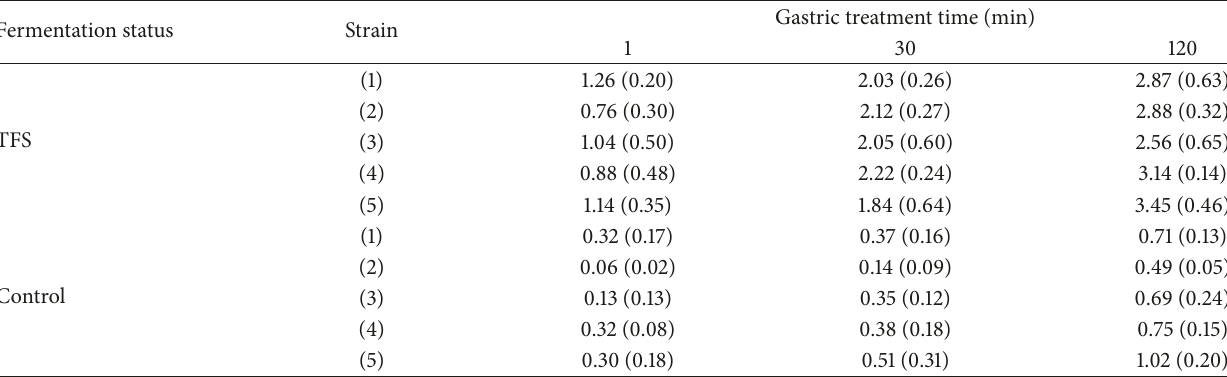
Table 3: Reduction of E. coli during gastric treatment ∗ .